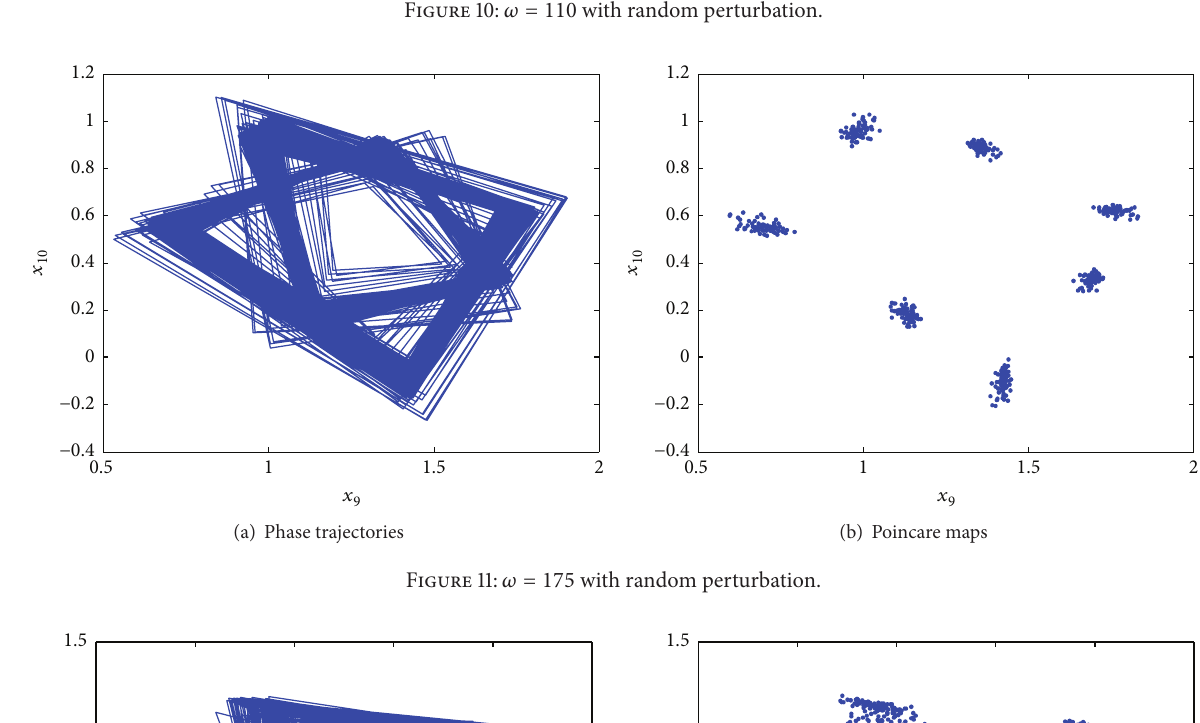
Figure 10: 𝜔 = 110 with random perturbation.